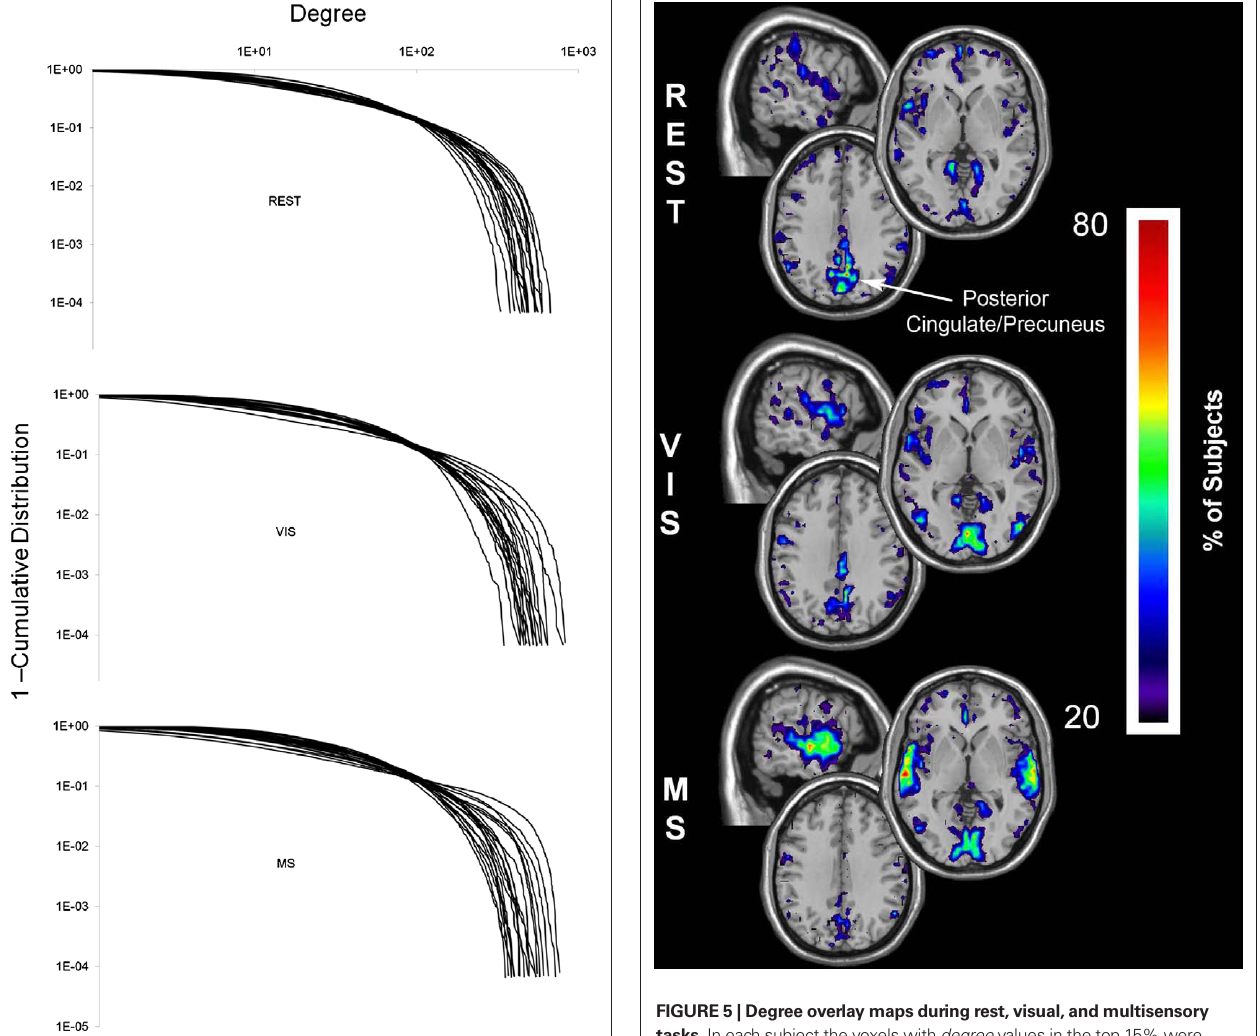
Figure 5 | Degree overlay maps during rest, visual, and multisensory tasks. In each subject the voxels with degree values in the top 15% were identified. These maps represent the overlap of these voxels across subjects in each of the three tasks. The consistency of overlap between across subjects is indicated by the threshold color bar that which represents the percentage of individuals for which each voxel was among the top 15%. Degree maps show that at rest (REST) the parietal cortex has the greatest connectivity while the visual cortex has lower degree . There is a regional shift in degree during the visual task (VIS) to the visual cortex and to both the visual and auditory cortex during the multisensory visual cortex during the visual task ( Figure 5 , VIS) and in both the visual and auditory cortices during the multisensory task ( Figure 5 , MS).